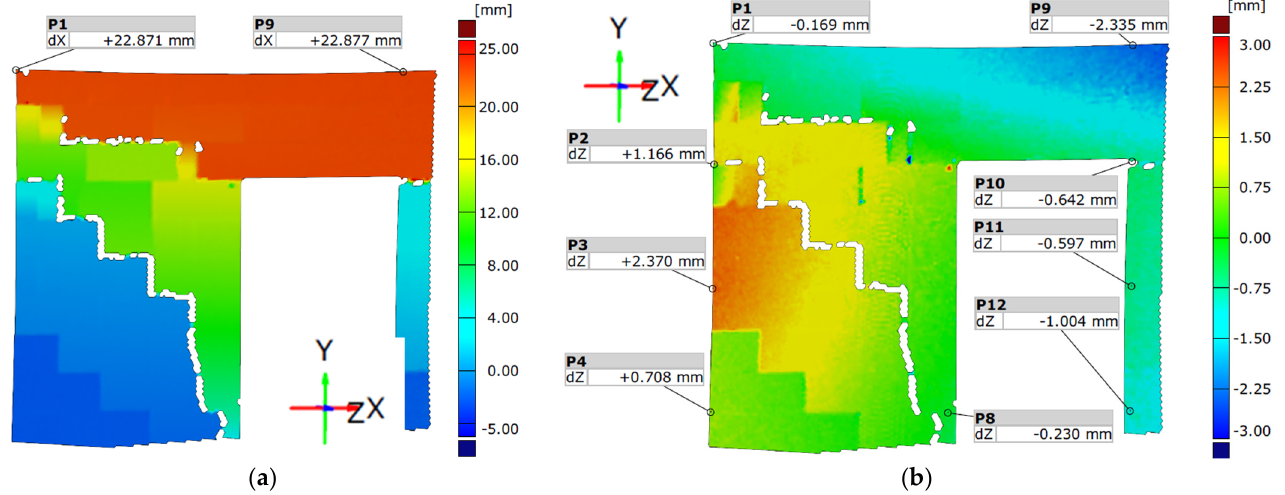
Figure 14. Post peak deformation analysis—MW-AAC-010/1 model— H x = 42.40 kN; ( a ) displacement along the X axis; ( b ) displacement along the Z axis.